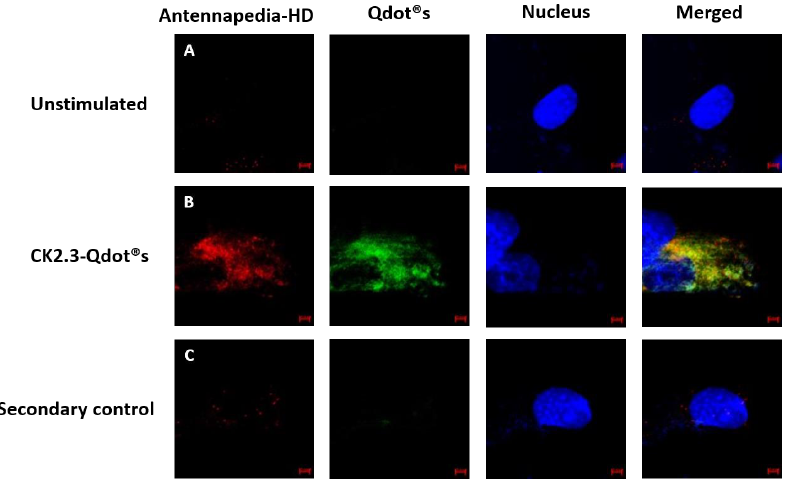
Figure 8. Co-localization of Antennapedia homeodomain signal sequence (red), incorporated within the sequence of CK2.3, and Qdot® s (green). ( A ): C2C12 cells were either left untreated or ( B ): treated